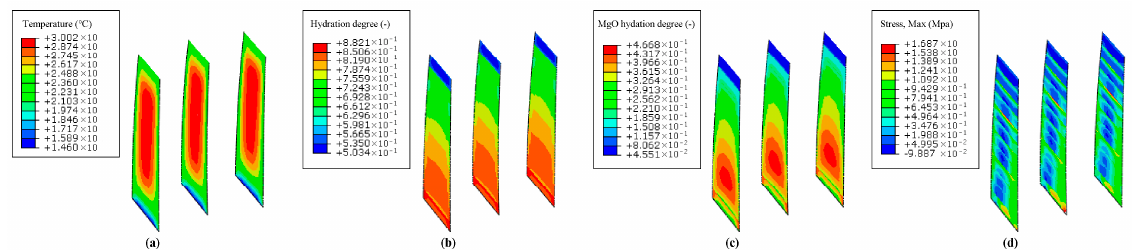
Figure 4. Coupled thermo-chemical-mechanical field computations on 1 March 2003. ( a ) Temperature (°C); ( b ) hydration degree of cementitious material (-); ( c ) hydration degree of magnesium oxide (-); ( d ) first principal stress (MPa).